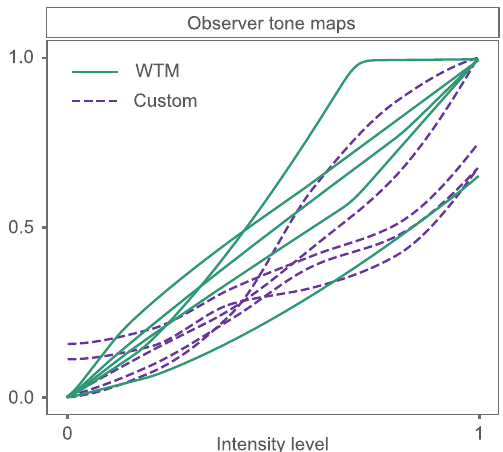
Figure 12. Example of observer tone-maps using WTM and the custom (control-point) enhancement. Custom tone-maps here could not be approximated by WTM i.e., they did not meet mean ∆ E ∗ threshold for